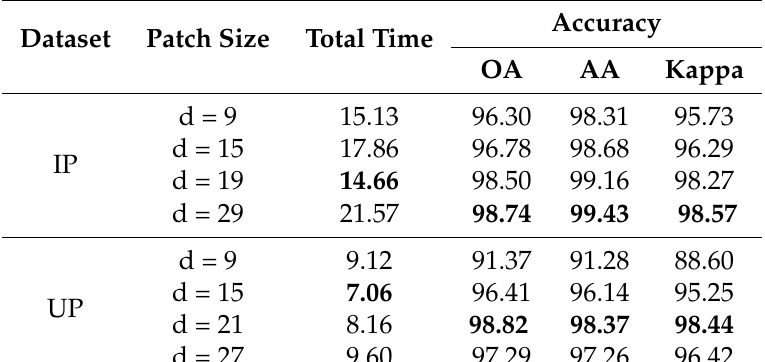
Table 10. Total training time (in minutes) and accuracy evaluation with different patch sizes d = 9, 15, 19, and 29 for the IP dataset and d = 9, 15, 21, and 27 for the UP dataset; the values in bold are the best. All results are the average of three runs with 100 samples per category; maximum epoch = 200 and mini-batch size = 24.